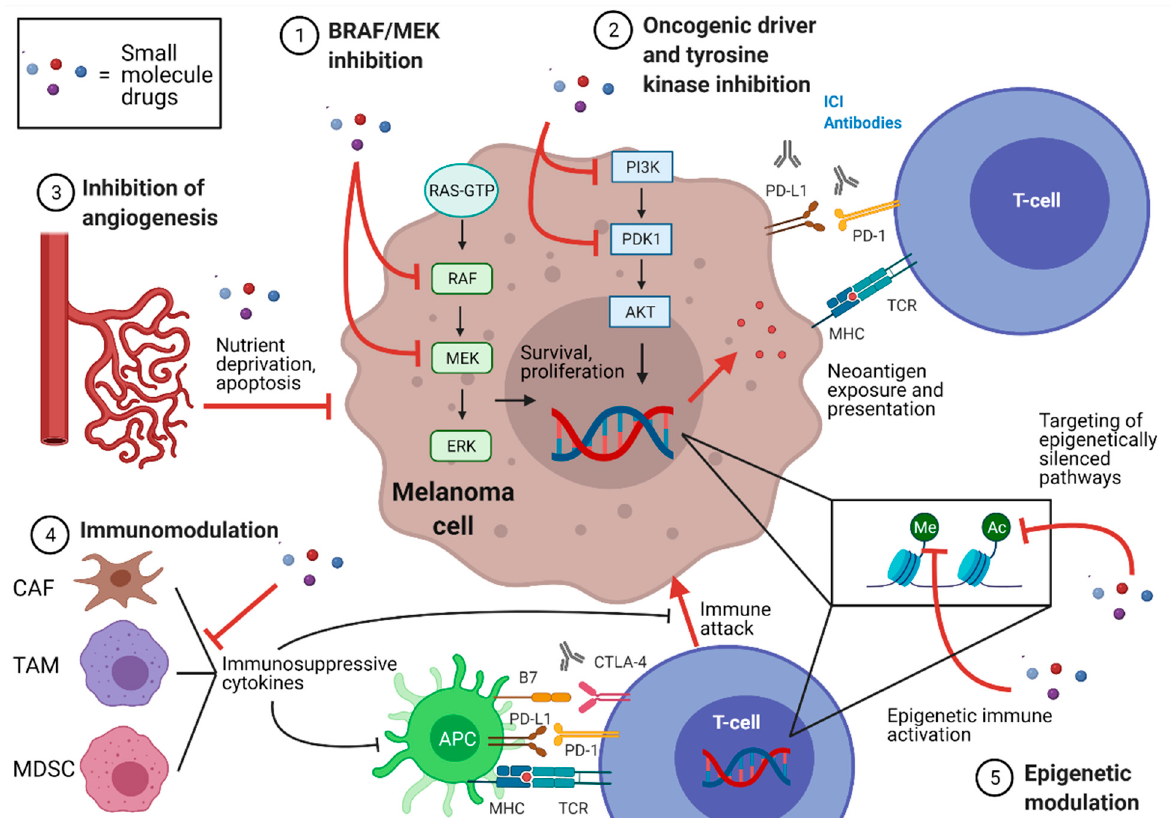
Figure 2. Potential mechanisms of synergy between small molecules and immune checkpoint inhibition in melanoma. Colored dots represent small molecule drugs. Intracellular ablation of Braf proto-oncogene/mitogen-activated protein kinase kinase (BRAF/MEK) in the mitogen activated protein kinase (MAPK) pathway (1), of oncogenic drivers such as those involved in the phosphoinositide-3-kinase/protein kinase B (PI3K/AKT) pathway or of other tyrosine kinases (2) induce apoptosis, resulting in increased presentation of neoantigens at the cell surface to primed and activated T-cells in the tumor microenvironment (TME). Extrinsic to the tumor cell, anti-angiogenic drugs (3) may impair nutrient delivery to tumor cells, resulting in tumor cell death and immune clearance. In the immune axis, immunomodulator drugs (4) may impair immunosuppressive cell types such as cancer associated fibroblasts (CAF), tumor associated macrophages (TAM), and myeloid derived suppressor cells (MDSC), including the cytokines they secrete which hinder cytotoxic T-cell function. Epigenetic modulator drugs may have bi-fold effects (5), exposing epigenetically silenced pathways (methylated, Me, or acetylated, Ac) within tumor cells, or alternatively activating pathways within immune effector cells including but not limited to immune checkpoints. APC (antigen presenting cell); MHC(major histocompatibility complex); RAS-GTP (Ras proto-oncogene guanosine triphosphate); ERK (extracellular signal-regulated kinases); PDK1 (phosphoinositide dependent kinase 1); TCR (T-cell receptor); PD-1 (programmed cell death protein-1); PD-L1 (programmed death-ligand 1); CTLA-4 (cytotoxic T-lymphocyte antigen